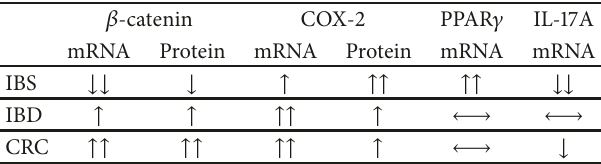
Table 3: The relationship between 𝛽 -catenin, COX-2, PPAR 𝛾 , and